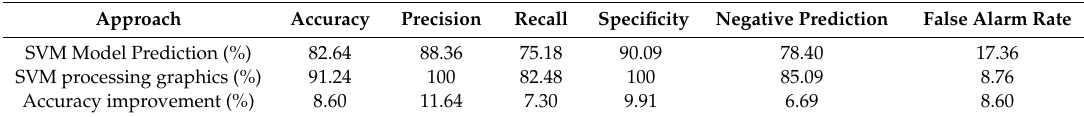
Table 7. Forecast evaluation